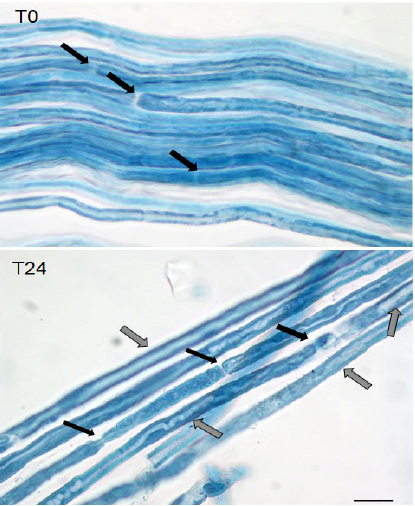
Figure 1. Sudan black staining of teased fibers from sciatic nerves. The fibers were analyzed imme- diately after dissection (T0) or after 24 h (T24) in culture. Black arrows indicate Ranvier nodes. The internode regions present a good levels of myelination at T0 with rare areas of demyelination (white areas). After 24 h from dissection, the areas of demyelination (white areas) are more evident (grey arrows) (scale bar = 20 μ m).